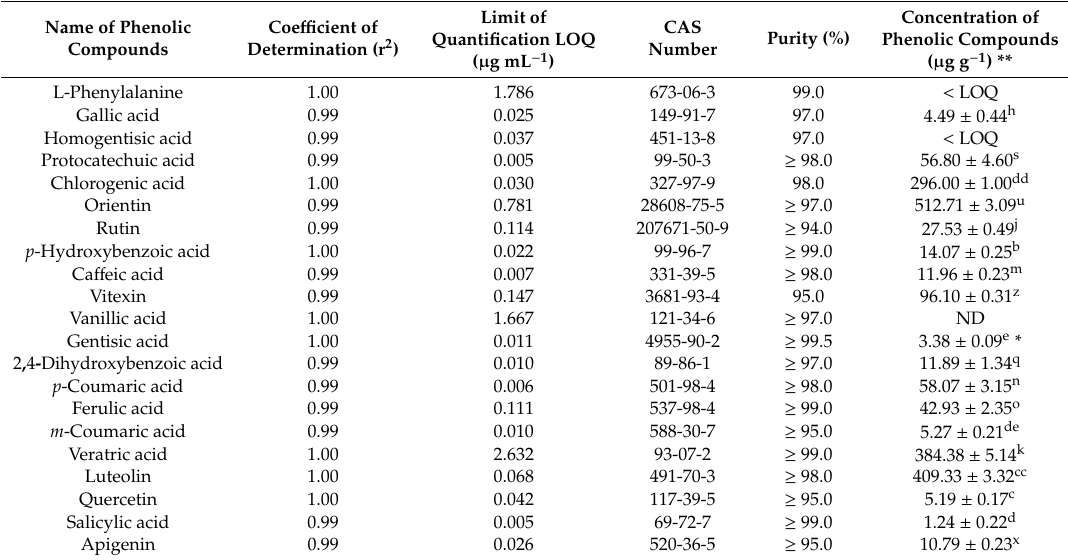
Table 2. Allelopathic compound contents of the methanolic extracts of Miscanthus leaves identified and quantified by LC-MS / MS.